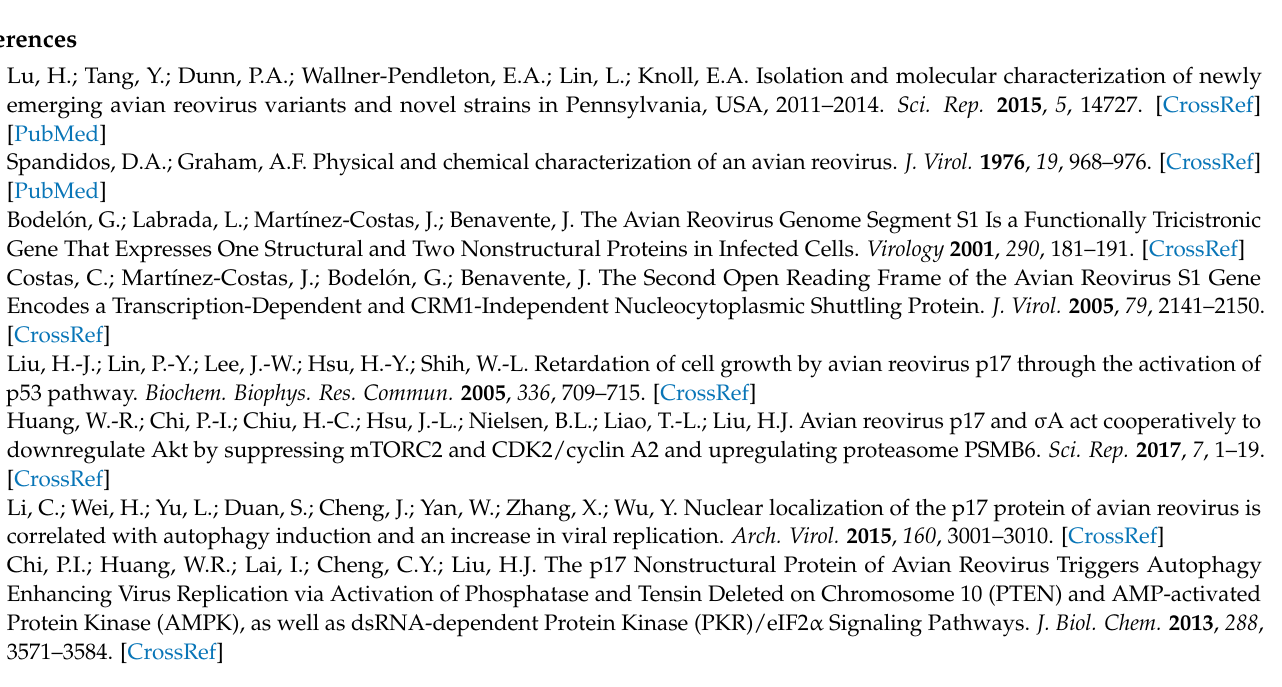
Figure S1B: Western blot analysis of recombinant GST and GST-ARV p17, Figure S1C: Immunofluo- rescence analysis of recombinant GST-ARVp17 in HUVEC